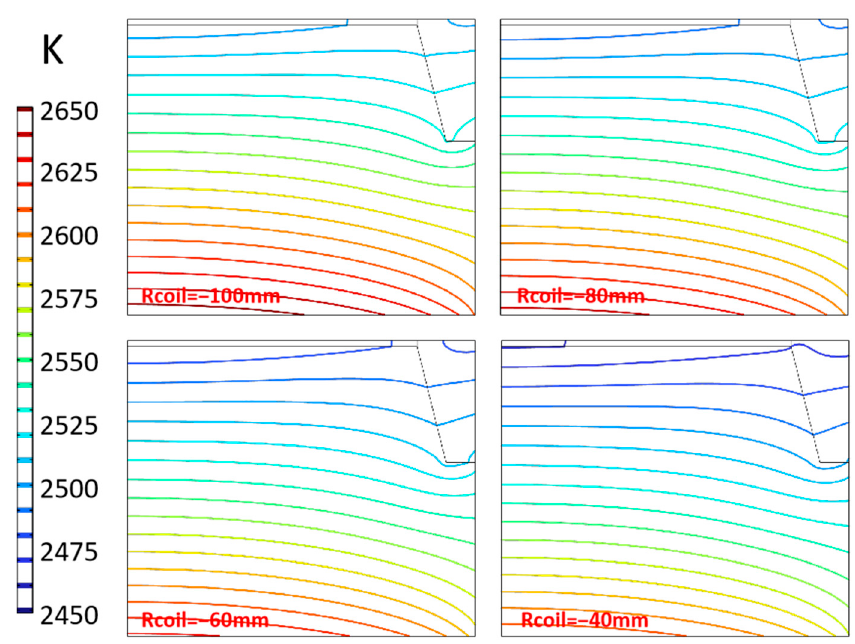
Figure 10. Temperature and temperature gradient at different power. ( a ) Temperature along surface of seed crystal; ( b ) Temperature gradient around seed crystal.